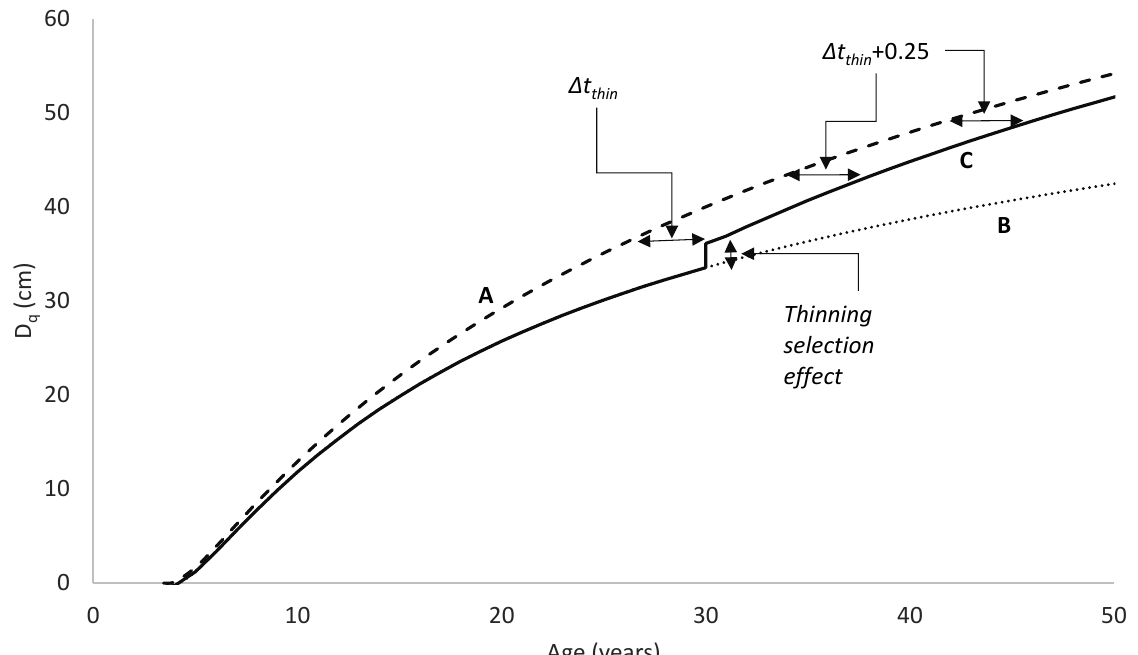
Figure 2. Diagram showing how D q is modelled in the redwood growth model for a stand thinned from 800 to 300 stems ha − 1 at age 30 years. The dashed line A is Equation (2) for a stand density of 300 stems ha − 1 and the dotted line B is Equation (2) for a stand density of 800 stems ha − 1 . The solid line C shows D q for the thinned stand. It follows line B until the thinning event, when thinning selection generally causes an immediate increase in D q . Thereafter, the thinned stand maintains a horizontal separation from line A equal to ∆ t thin , increasing slightly to ∆ t thin +0.25 after one year to allow for crown expansion following thinning.